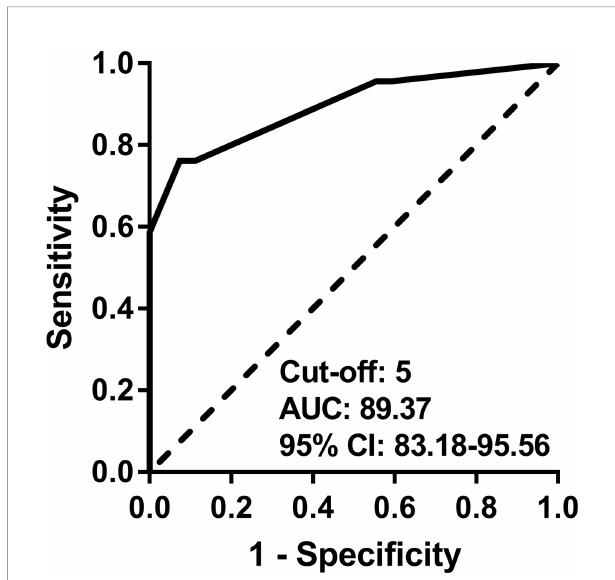
FIGURE 1 | ROC curve for discriminating active disease and inactive disease using the new disease activity assessment tool. AUC, area under the curve; CI, con fi dence interval; ROC, receiver operating